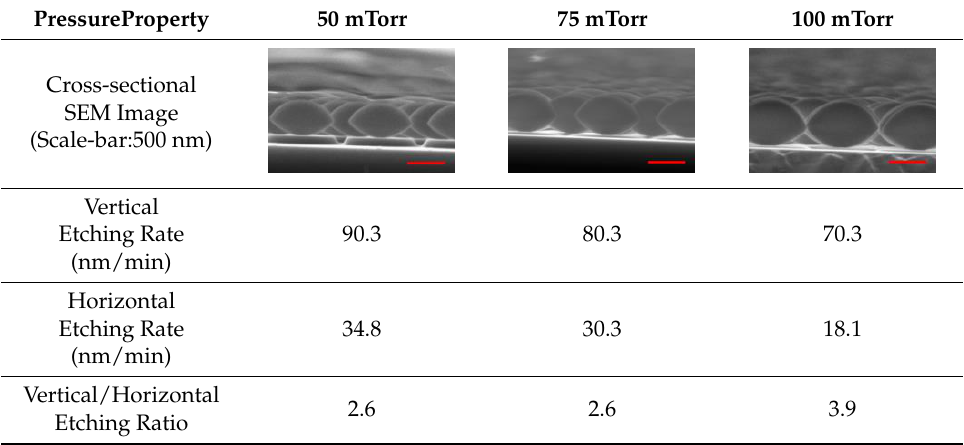
Figure 4. SEM images of RIE processed SS after different etching time ( a ) 10 min, ( b ) 13 min, ( c ) 16 min, and ( d ) 19 min, ( e ) graph indicating inter-particle spacing with etching time (All samples were etched at the same RIE condition which are 75 mTorr pressure, 200 Watts RF power, and 25/25 sccm gas flow rate except etching time) (scale bar:1 um). Table 1. SS shape profile change with CHF 3 /Ar gas RIE after 10-min etching under three different chamber pressures.